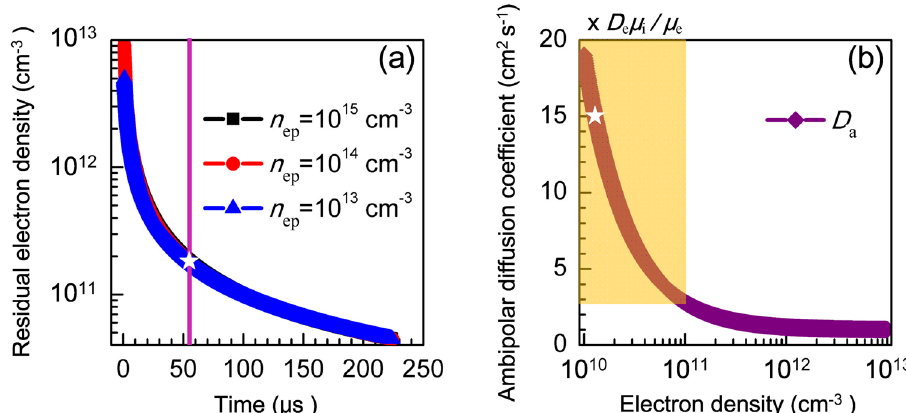
Fig. 4 The effect of residual charged particles on the ambipolar diffusion. a Plots of the residual electron density as a function of the time under three different initial peak electron densities, i.e., 1.0 × 10 13 cm − 3 (blue solid triangle), 1.0 × 10 14 cm − 3 (red solid circle), and 1.0 × 10 cm − 3 (black solid square). n ep represents the initial peak electron density. The label (white star) shows a typical point, where the residual electron density approximately decays to be the same value 1.8 × 10 11 cm − 3 within a short period of time (54.5 μ s, indicated by the magenta vertical line segment) under the three different initial peak electron densities. b Variation of the ambipolar diffusion coef fi cient (purple solid diamond) with the number density of newly produced electrons in the streamer channel. μ e , μ i , D e , and D a are the electron mobility, ion mobility, free diffusion coef fi cient of electrons, and ambipolar diffusion coef fi cient, respectively. The label (white star) denotes a typical point, where the growth multiple of ambipolar diffusion coef fi cient increases to 15 with the electron density on the level of 10 10 cm − 3 near the edge of the streamer channel. The shaded region is introduced in order to focus the attention on the considerable growth of the ambipolar diffuse coef fi cient near the edge of the streamer